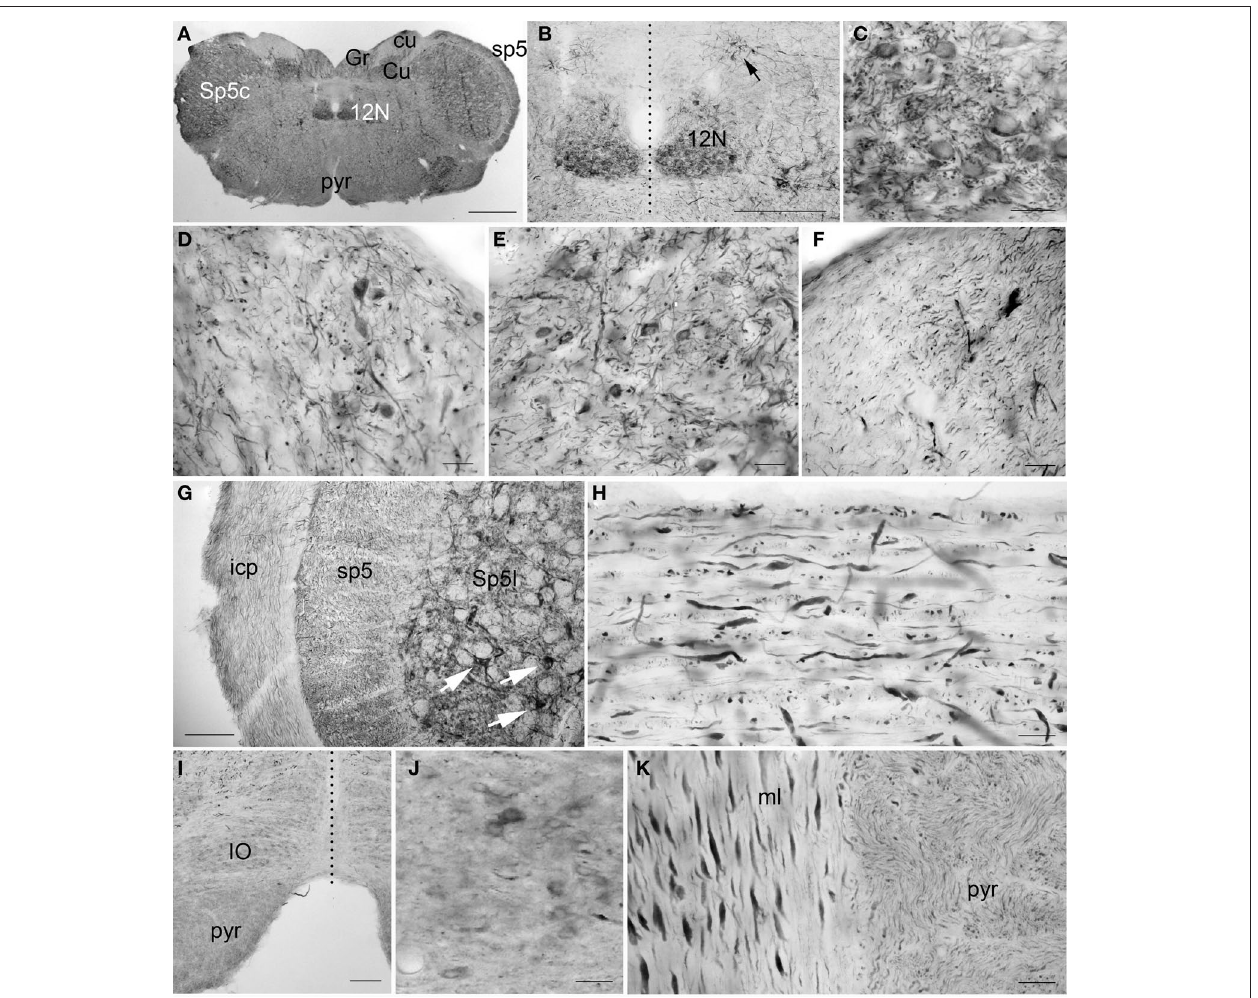
Figure 11 | PlexinA4 in the medulla. Micrographs of coronal (A–g and i–J) , sagittal (H) and horizontal (K) sections through the adult rat medulla stained for PlexinA4. PlexinA4 neuronal staining is most intense in the hypoglossal nucleus (12N; A–C ), the gracile nucleus (Gr; A and D ), the cuneate nucleus (Cu; A and e ), the spinal trigeminal nucleus (Sp5; arrows in g ) and the A2 noradrenaline cell group (arrow in B ). Less intense but visible labeling is also seen in the neurons of the inferior olive (IO; i and J ). Large caliber fibers positive for PlexinA4 are present in the inferior cerebellar peduncle (icp; g ), the spinal trigeminal tract